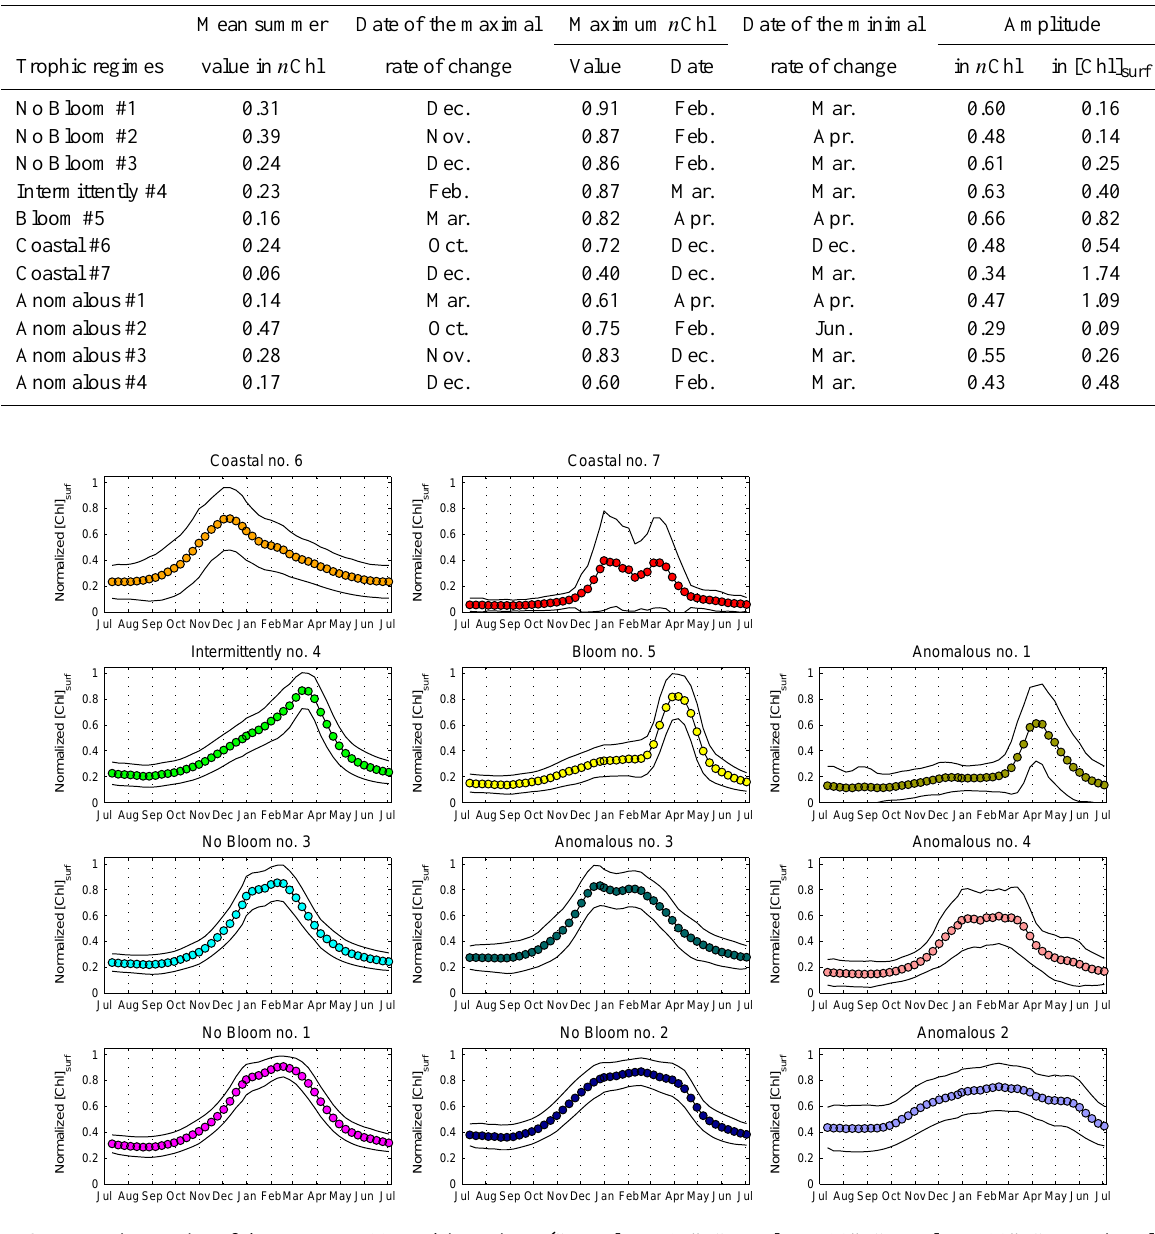
Figure 2. Mean time series of the seven DR09 trophic regimes (“No Bloom #1”, “No Bloom #2”, “No Bloom #3”, “Intermittently #4”, “Bloom #5”, “Coastal #6” and “Coastal #7”) and of the four “Anomalous” trophic regimes (“Anomalous” #1, #2, #3 and #4) obtained from our method. Standard deviations are indicated as black